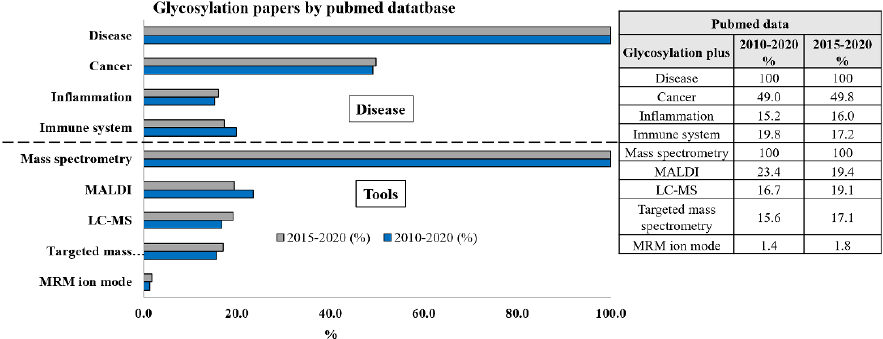
Figure 1. The number of papers calculated along a period of 5 to 10 years by the PubMed platform.